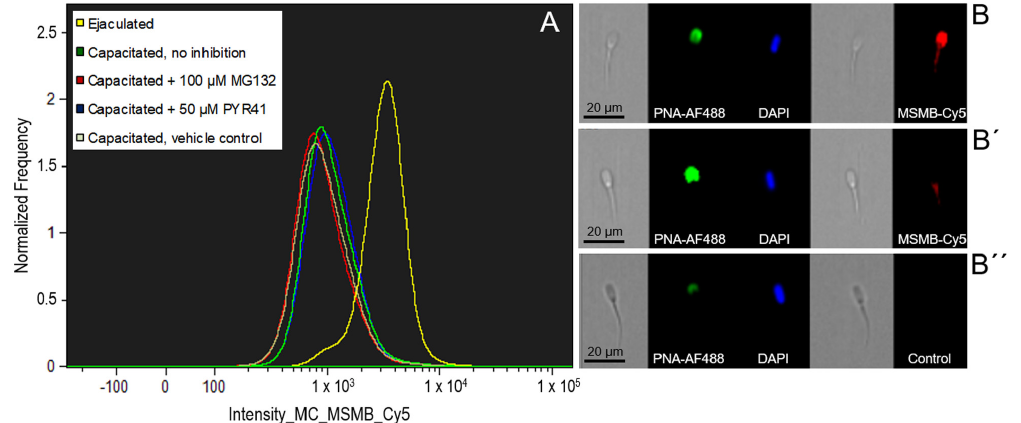
Figure 2. A representative flow cytometric histogram of MSMB changes during sperm in vitro capacitation without or under proteasomal (100 µ M MG132) / E1 (50 µ M PYR41) inhibiting conditions including vehicle control. The mean value of all flow cytometric measurements showed a higher fluorescence intensity in ejaculated spermatozoa ( A ). Representative image galleries of ejaculated spermatozoa ( B ), capacitated spermatozoa ( B’ ), and negative control spermatozoa incubated with non-immune serum in place of anti-MSMB antibody ( B” ). Nuclei were counterstained with DAPI (blue); acrosomal integrity was monitored with lectin PNA (green) and binding of MSMB-Cy5 antibody (red). Every flow cytometric run represents 10,000 events. The experiment was replicated four times.